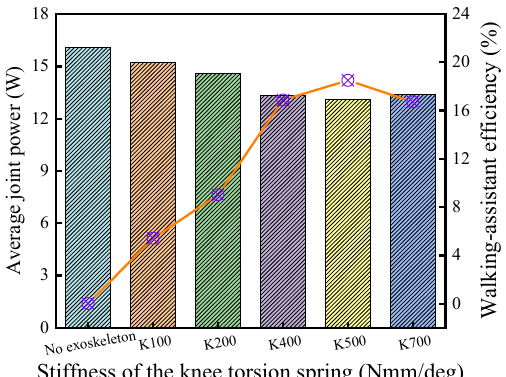
Figure 13. Walking ‐ assistance efficiencies of the KESM.